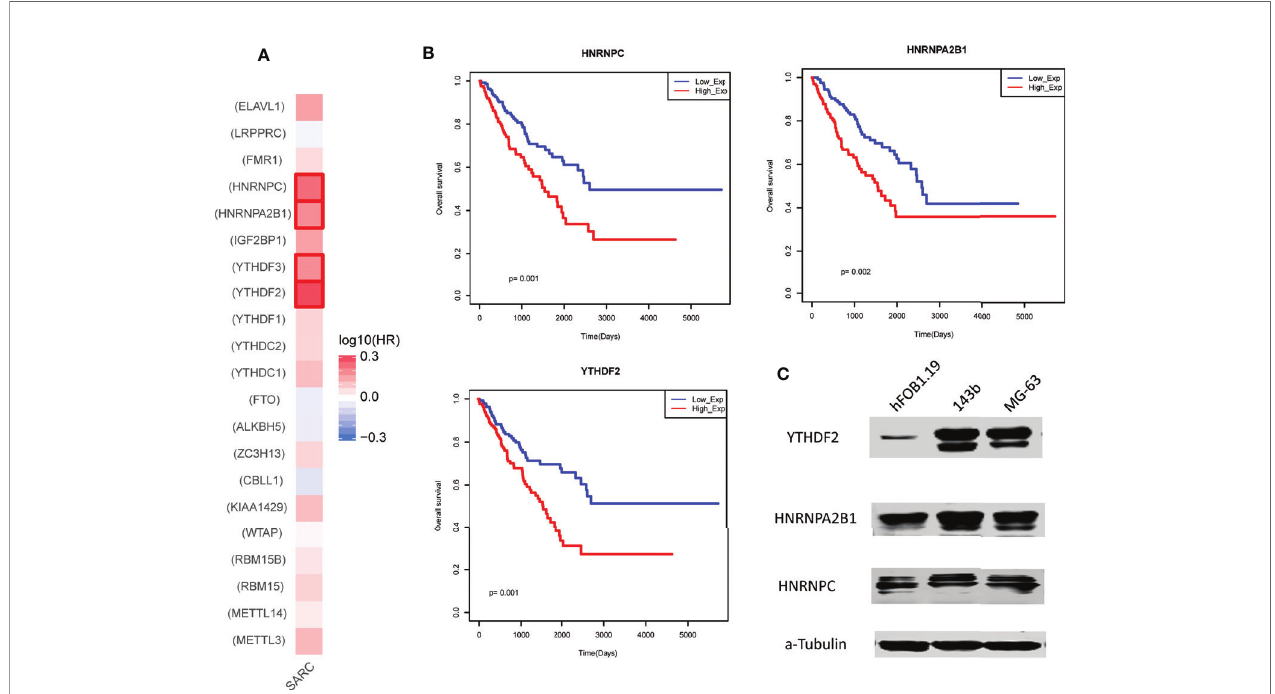
FIGURE 3 | Prognostic effects of individual m6A regulator in sarcoma. (A) The hazard ratios of m6A regulators in sarcoma. Red marked regulators represent statistically signi fi cant risk factors (HR>1). (B) The Kaplan-Meier survival curve of the 3 regulators with high hazard ratios. Low_Exp group and High_Exp group were divided by mean expression. (C) Expression of the 3 regulators in control and model osteosarcoma cell lines. a -Tubulin was used as the